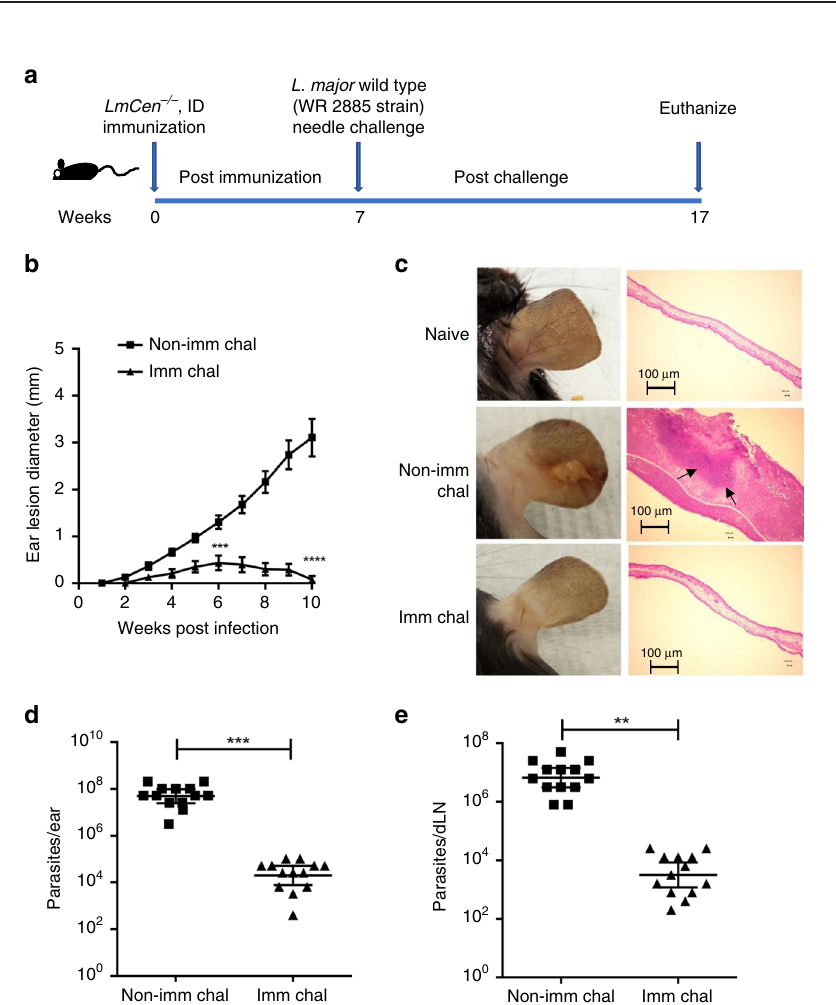
Fig. 3 Safety and non-pathogenicity characteristics of LmCen − / − parasites. a BALB/c; b STAT1 KO; c IFN- γ KO and d Rag2 KO mice were subcutaneously inoculated with indicated doses of LmWT or LmCen − / − into the right hind footpad. a BALB/c mice ( LmWT , n = 5) or ( LmCen − / − , n = 7) c IFN- γ KO mice ( LmWT , n = 4) or ( LmCen − / − , n = 6), d Rag2 KO mice ( LmWT , n = 6) or ( LmCen − / − , n = 6) were infected with 1 × 10 7 of LmWT (Friedlin V9) or LmCen − / − and b STAT1 KO mice were infected with 2 × 10 8 of LmWT (Friedlin V9) ( n = 4) or LmCen − / − ( n = 4) parasites. Following infection, footpad swelling was measured weekly by digital caliper. Parasite burden in infected footpad was measured at 5 weeks after infection in BALB/c ( LmWT , n = 4) and ( LmCen − / − , n = 4), at 7 weeks in STAT1 KO ( LmWT , n = 5) and ( LmCen − / − , n = 5) or at 15 weeks in IFN- γ KO ( LmWT , n = 4) and ( LmCen − / − , n = 4) and at 15 weeks in Rag2 KO ( LmWT , n = 6) and ( LmCen − / − , n = 6). For the lesion development studies shown in a – d (left panels) as SEM a, c and d and as SD b and for parasite burden studies shown in a – d (right panel) as mean ± SEM a, c and d and as mean ± SD b , unpaired two-tailed t-test (* p − 0.04, ** p − 0.009, *** p < 0.0009, **** p < 0.0001). The differences in footpad swelling were statistically signi fi cant at all time points after the initial observation of the lesion. Experiments representing a , b and c performed twice; and experiment representing d performed only one time. e Schematic representation of the DXM treatment. f Photographs of one representative ear of LmWT infected (group-1) ( n = 6), LmCen − / − (group-2) ( n = 6) and (LmCen − / − + DXM) (group-3) ( n = 12) mice from one of two independent experiments. Scatter dot plots of parasite load in the infected ear g and in the draining lymph node (dLN) h of each LmWT ( n = 6) and LmCen − / − ( n = 6) and LmCen − / − + DXM ( n = 12) immunized mice. Parasite burden was determined by limiting dilution assay. Results are expressed as mean ± SEM and data pooled from two independent experiments. Statistical analysis was performed by unpaired two-tailed t-test (** p − 0.004, *** p − 0.0006).